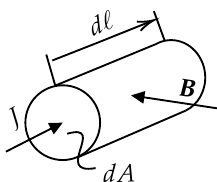
Figure 12. Infinitesimal conductor portion powered by a current density J immersed in a magnetic field of flux density value B